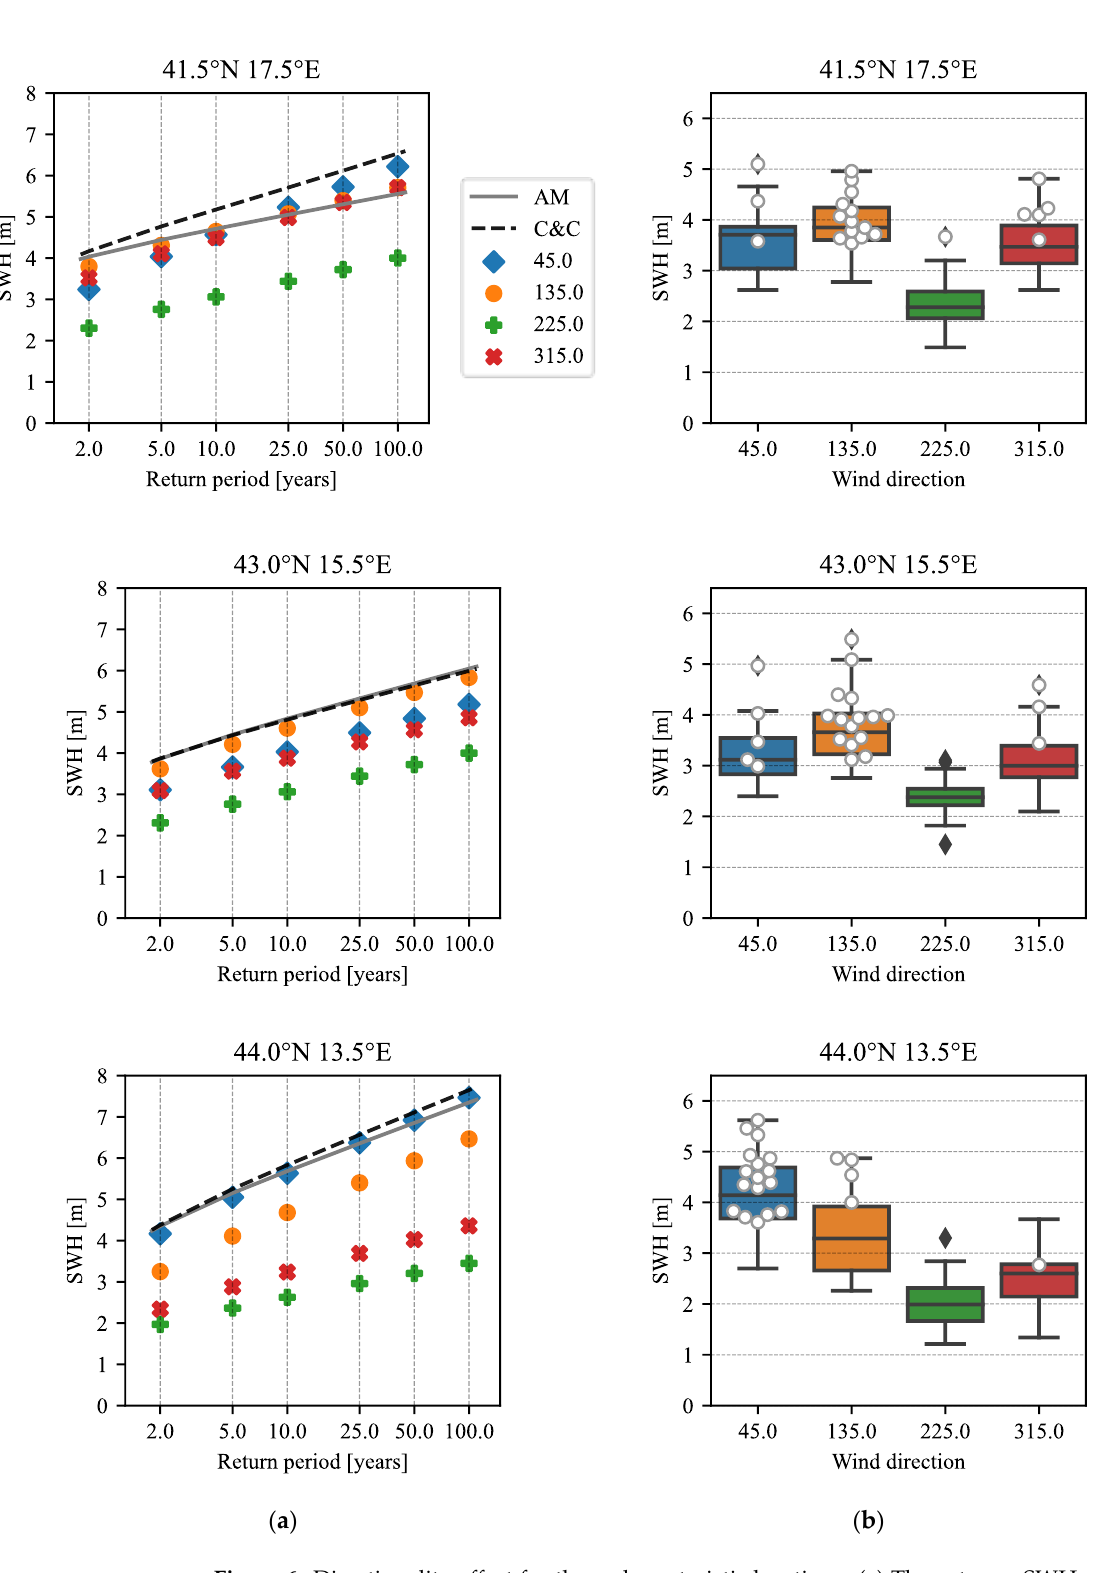
Figure 6. Directionality effect for three characteristic locations: ( a ) The extreme SWHs calculated based on different return periods. Markers represent results from individual directions, while the dashed black line displays values obtained by the C–C approach combining DM; ( b ) Box plot describing the dispersion of maxima that occurred in a given direction. White circles highlight the values that are also the annual maxima that occurred in a given direction.